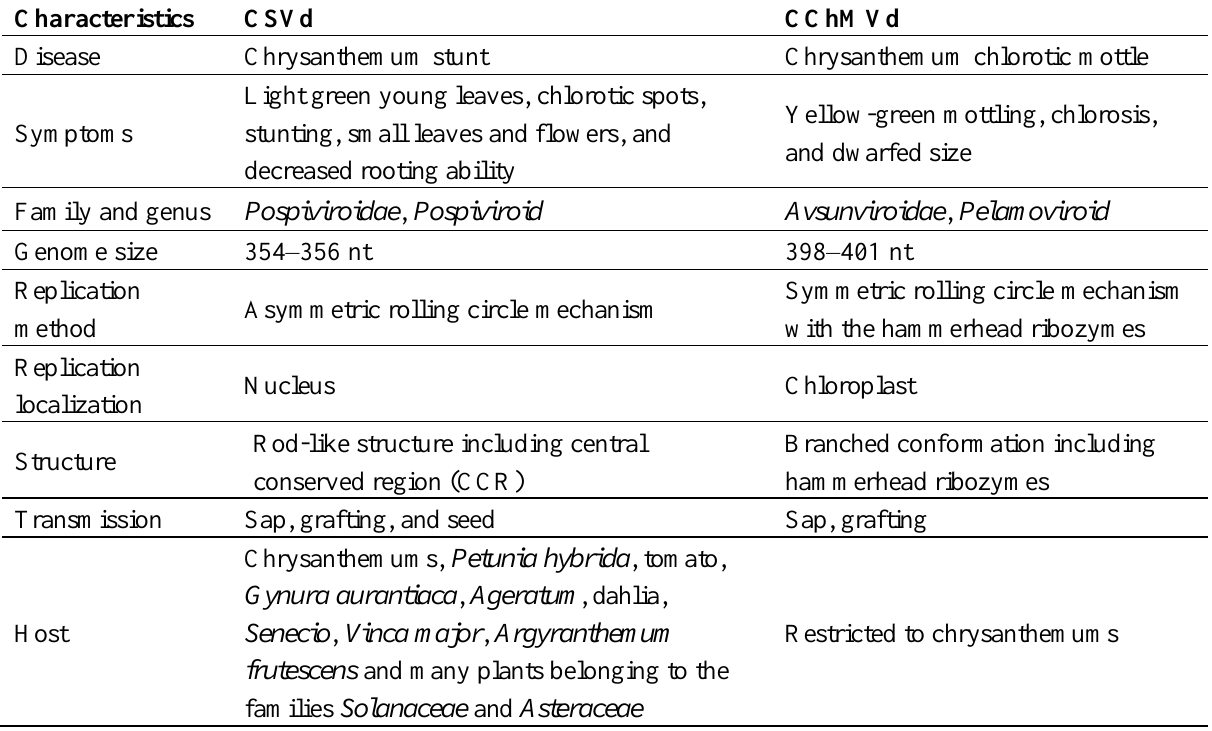
Table 1. Characteristics of CSVd and CChMVd